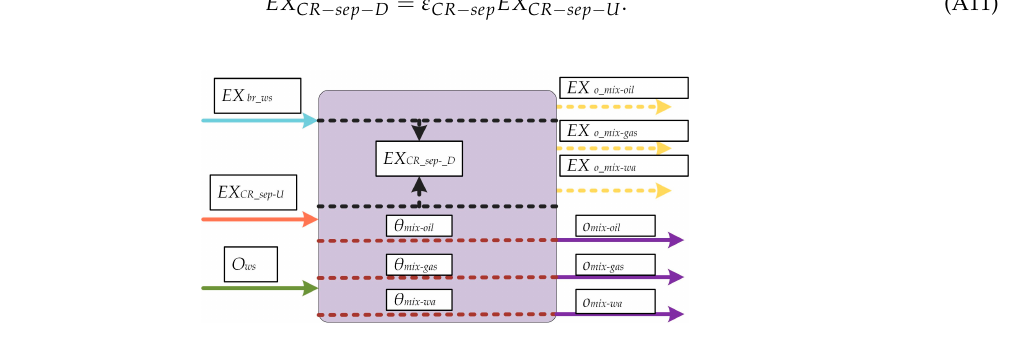
Figure A2. Process flowsheets of CR-sep .